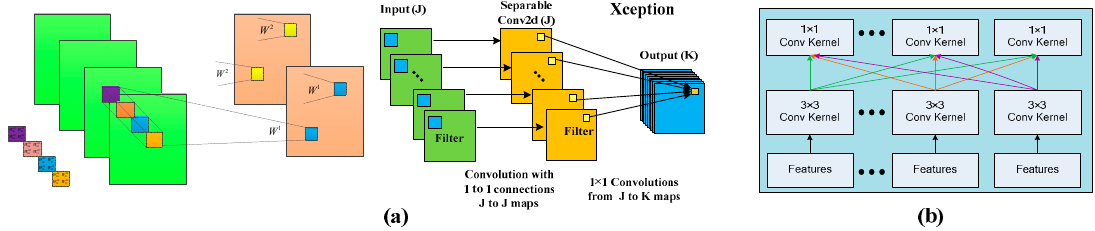
Figure 2. Convolution module ( a ), Standard convolution module ( b ), Depthwise separable convolution module.